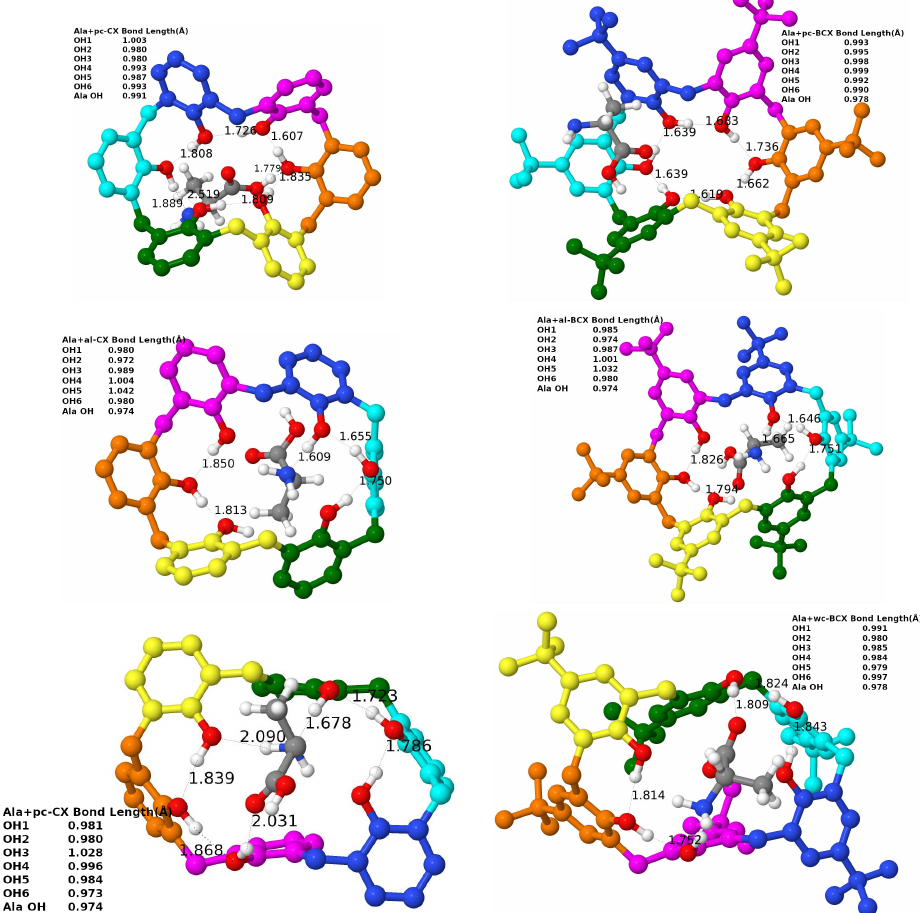
Figure 3. Selected bond lengths for O-H and H-bonds for the case of complexes with Ala. Hydrogen atoms of calixarenes are removed for a better